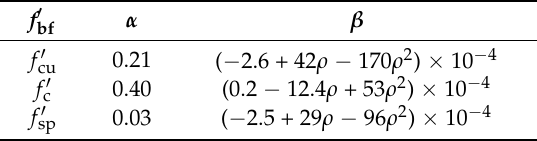
Table 8. α and β in the strength formula.